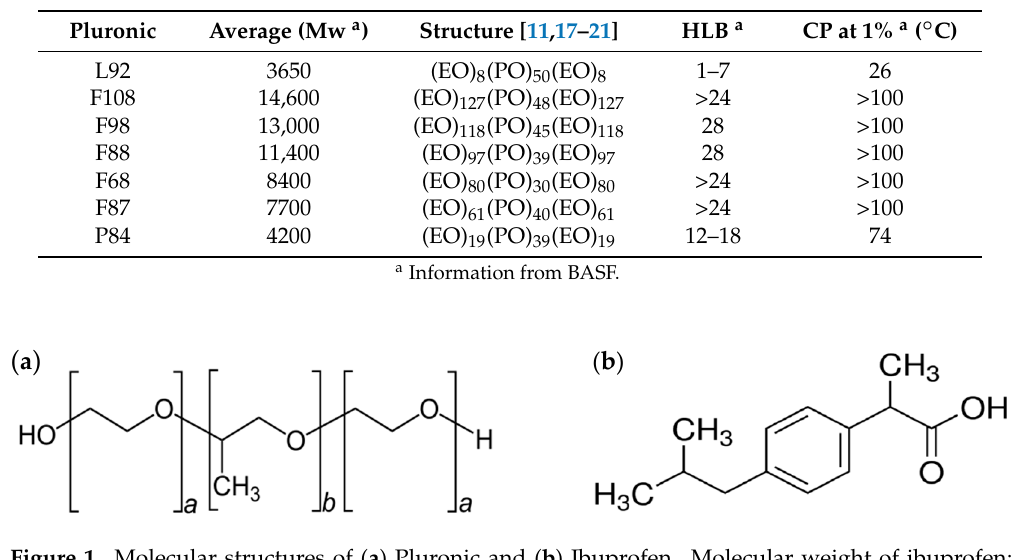
Table 1. Physicochemical characteristics of Pluronics used.